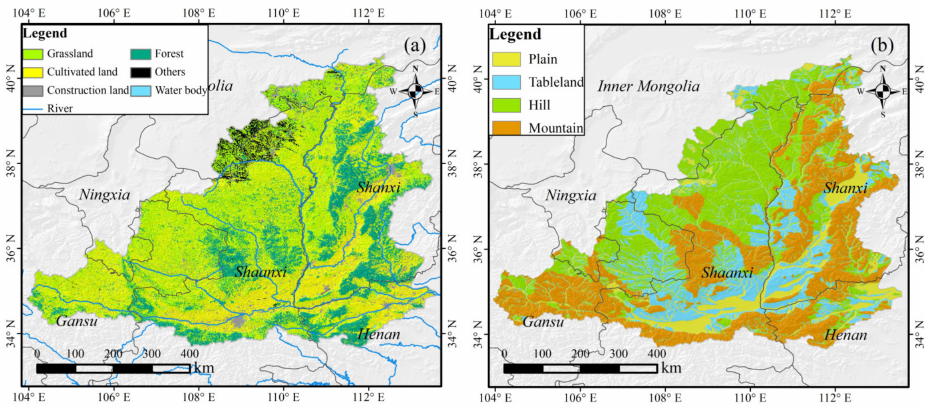
Figure 1. The spatial distribution of vegetation types ( a ) and geomorphic types ( b ) in the middle reaches of the Yellow River Basin